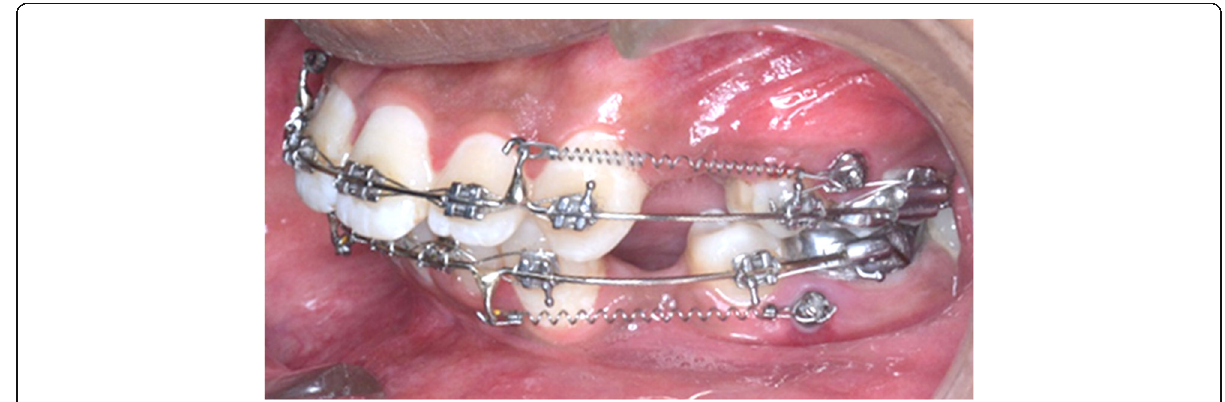
Fig. 1 Loading of the miniscrew implant with Nitinol close coil spring (9 mm, 200-g